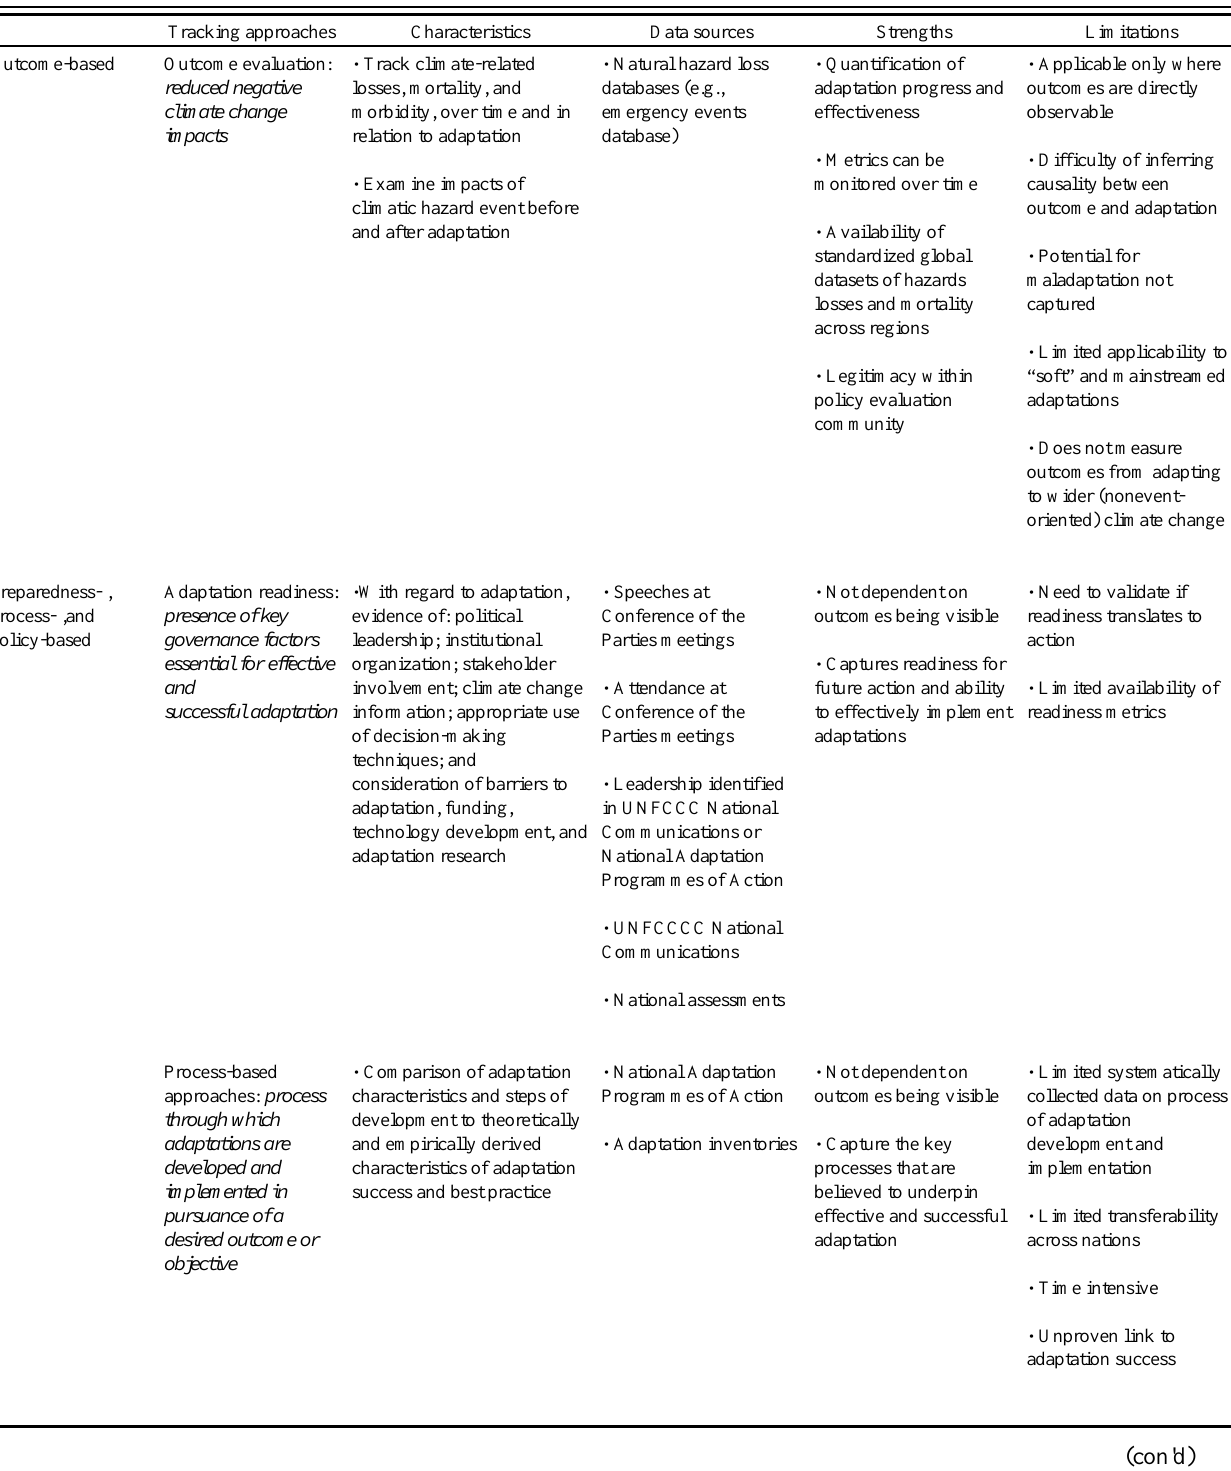
Table 1 . Typology of approaches for adaptation